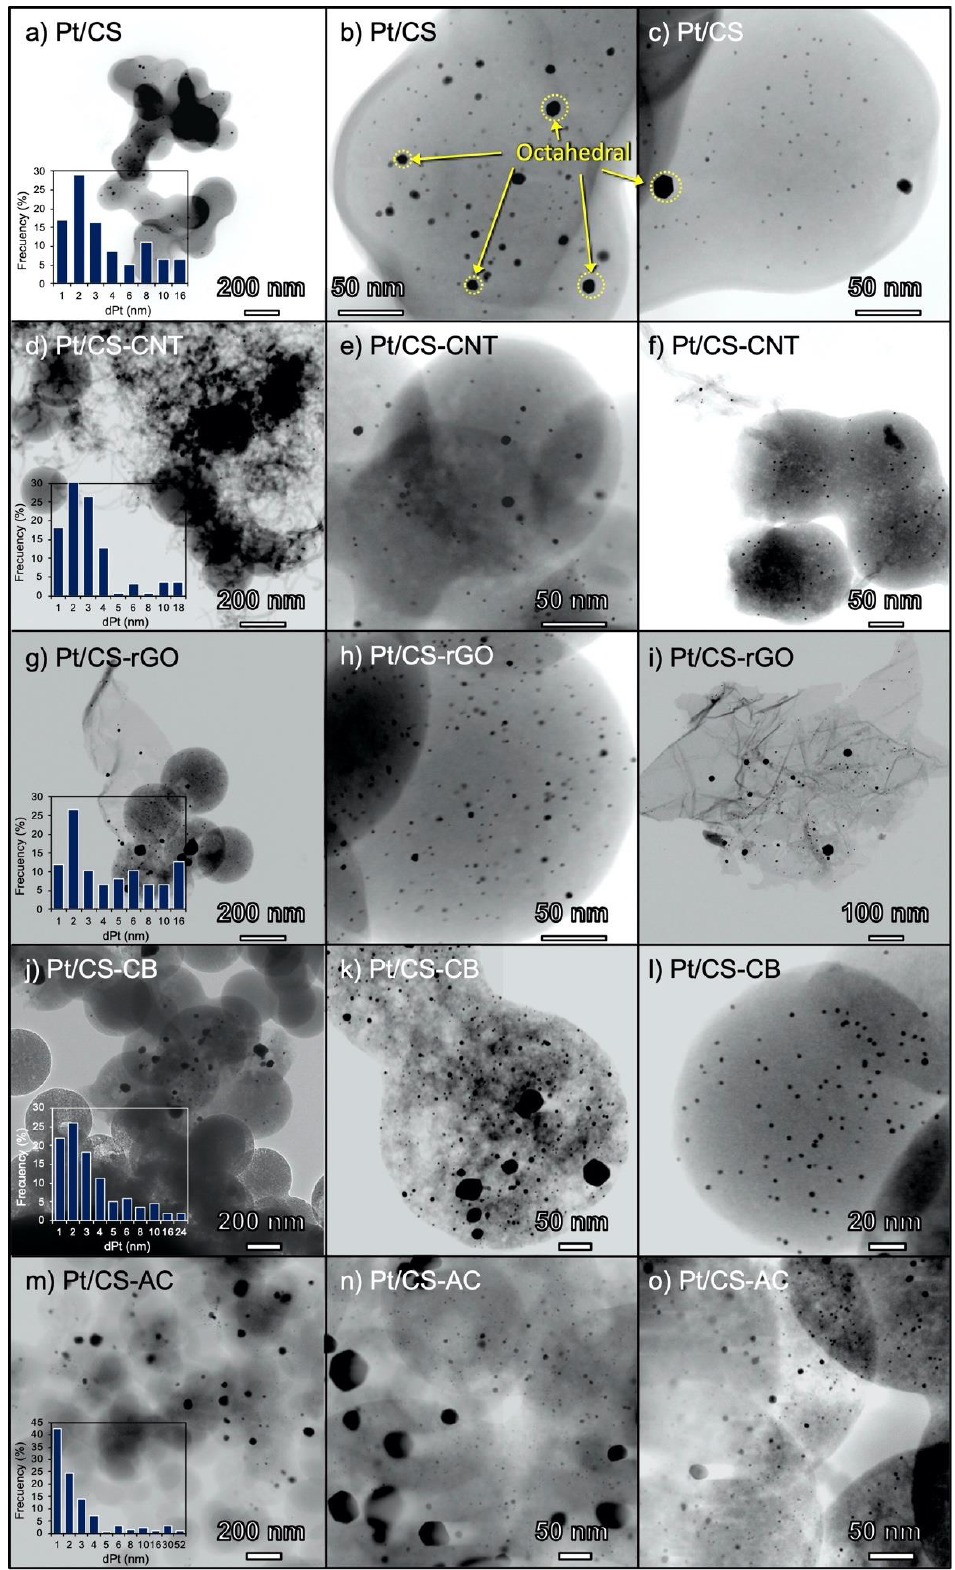
Figure 5. TEM images and histograms (inset) of Pt-catalysts supported on glucose–carbon hybrids: ( a – c ) Pt/CS, ( d – f ) Pt/CS- CNT, ( g – i ) Pt/CS-rGO, ( j – l ) Pt/CS-CB and ( m – o ) Pt/CS-AC.